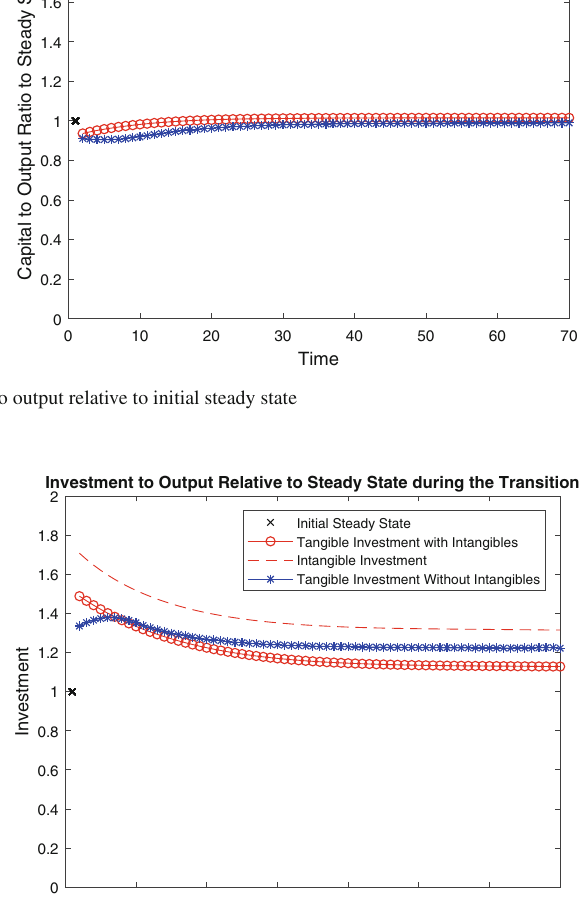
Figure6presentstheRamseyallocationoflaborandeffort.Wefindthatthepresence of intangibles affects the level of labor, but not the timing of the optimal labor